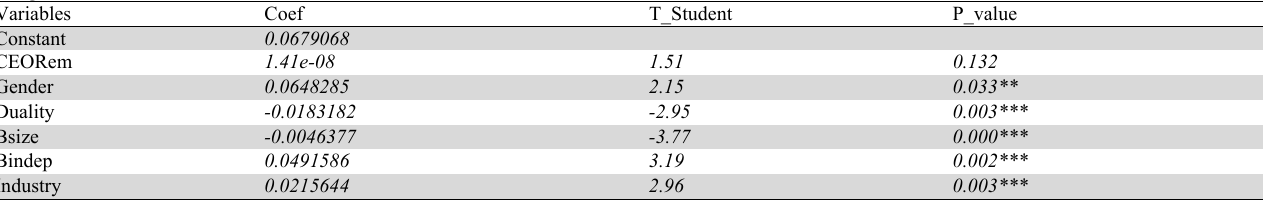
Regression results for M2